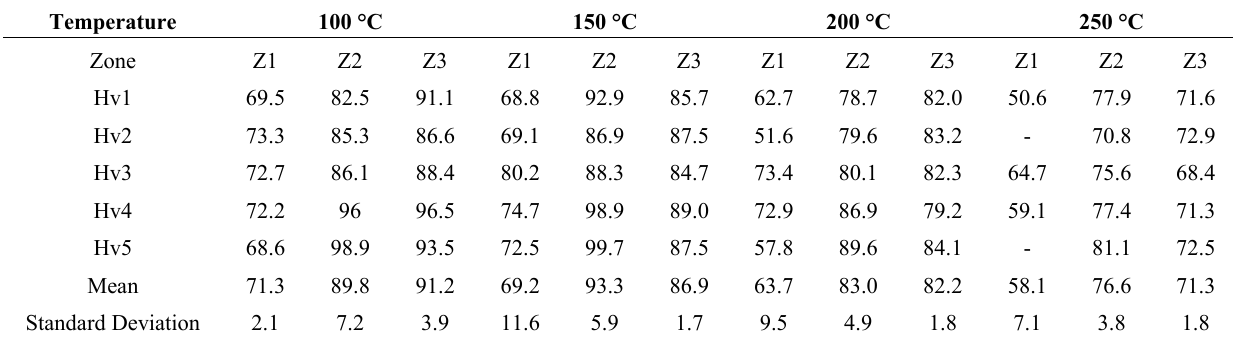
Table 1. Microhardness values for the N0 forged connecting rods.